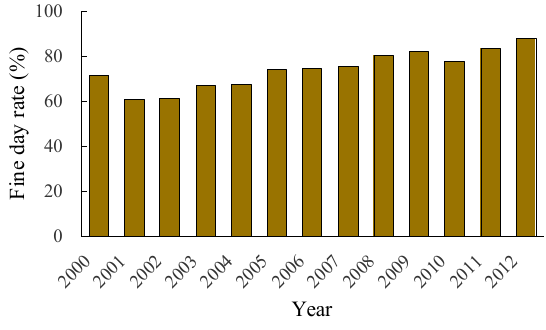
Figure 4. Percentage of days with good air quality in each year.